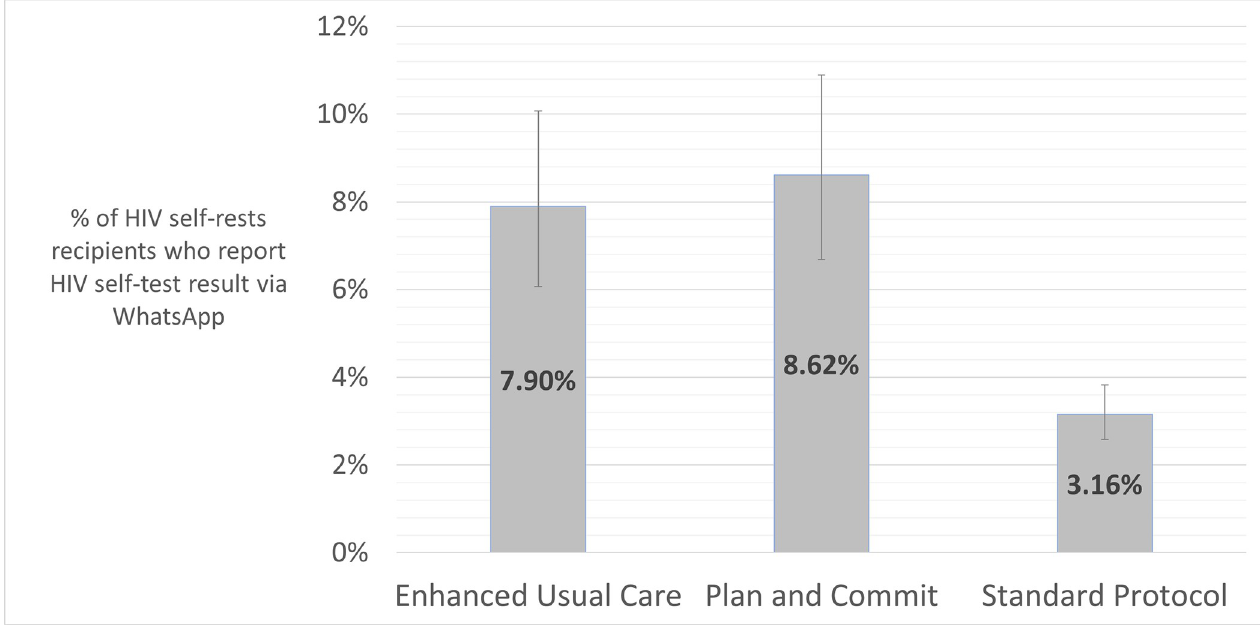
Fig 2. Proportion of participants reporting HIV self-screening test results via WhatsApp messaging, by treatment arm, Tshwane Metropolitan Municipal District, 2019 (N = 4,677 total participants).